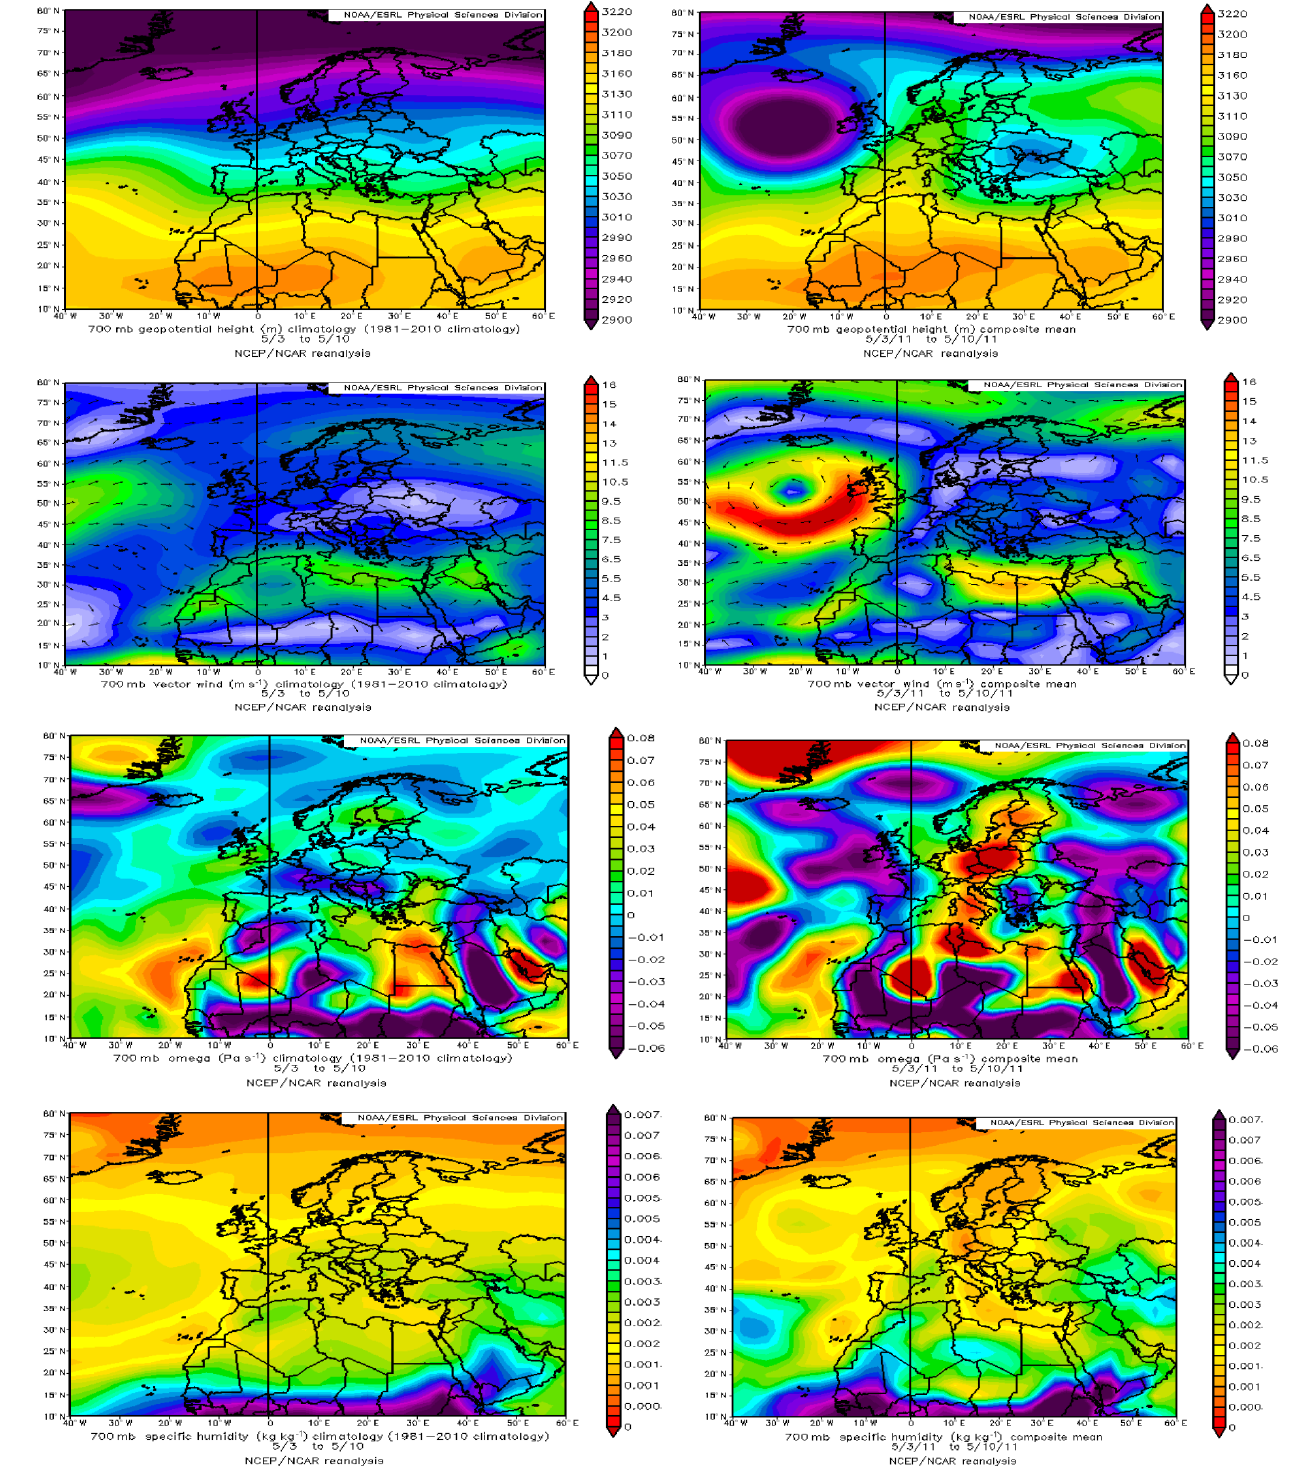
Figure 2. Composite NOAA/ESRL weather maps of geopotential height, vector wind speed, omega vertical velocity and specific humidity for 3–10 May climatology (left column) and for the episode of 3–10 May 2011 at JRC Ispra, Italy (right